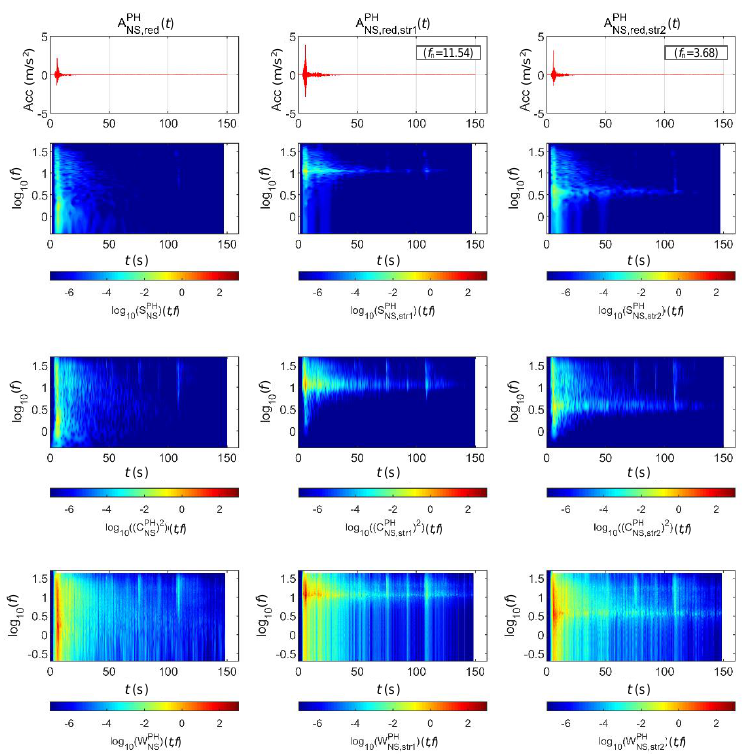
Figure 16. Analysis results of the Pohang earthquake data (scaled for 2400-year return period) and associated bridge response.